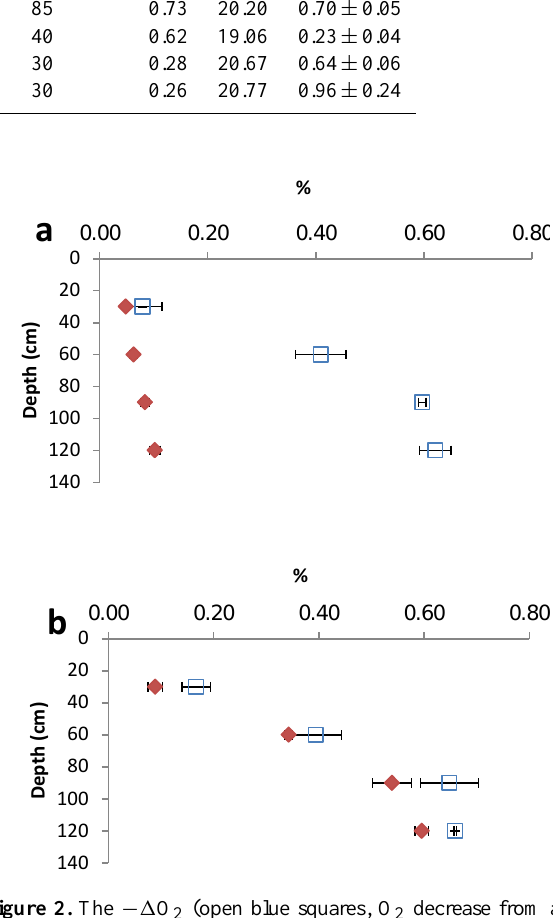
Figure 1. Temporal variations in depth profiles of − (cid:49) O 2 (open blue squares, O 2 decrease from ambient) and 0.76 (cid:49) CO 2 (red di- amonds, CO 2 increase above ambient corrected for lower gas diffu- sivity compared to O 2 ) profiles in the soil of site 1 (citrus orchard).